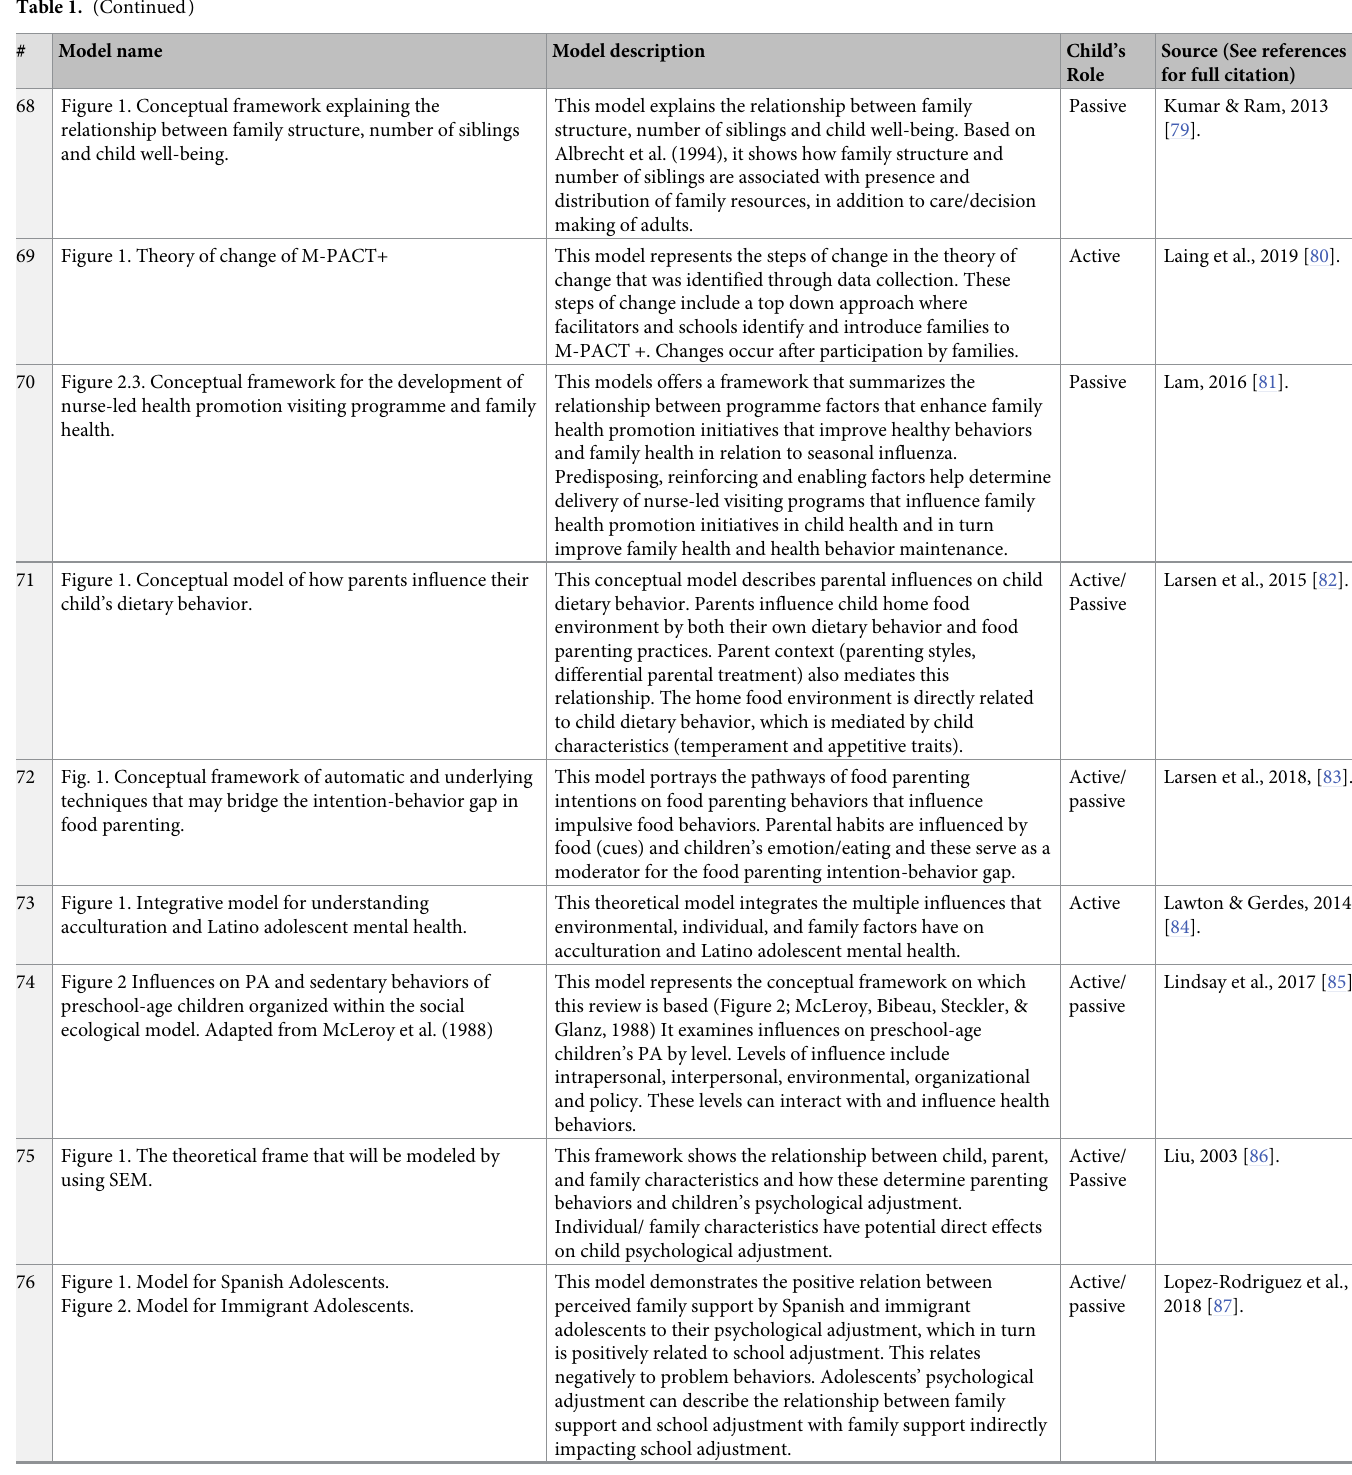
Figure 1. Conceptual framework explaining the relationship between family structure, number of siblings and child well-being.